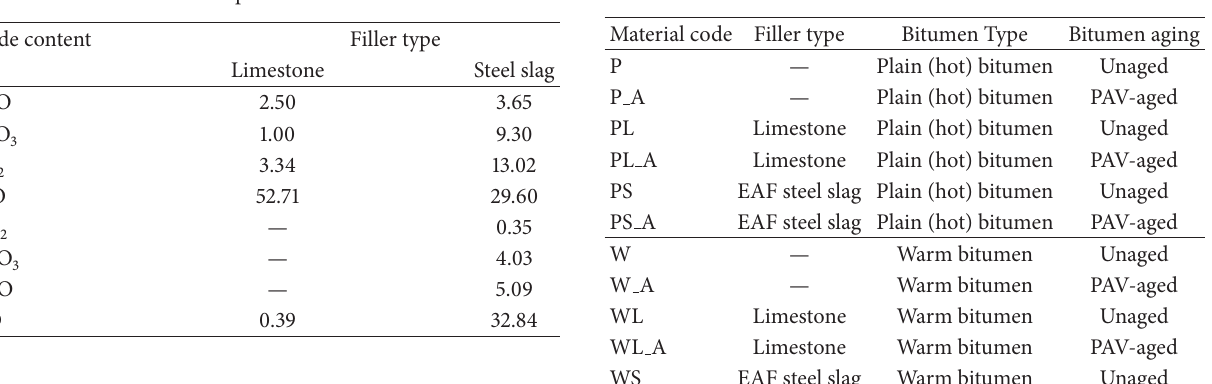
Table 3: Chemical composition of the studied fillers. Table 4: Tested